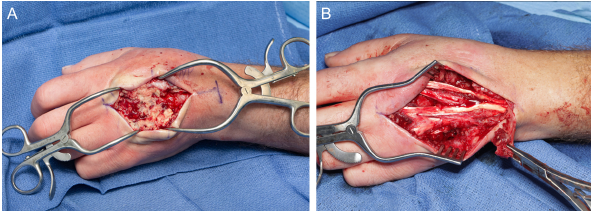
Figure 10. Intraoperative appearance of the left wrist showing (a) extensive purulent material superficial to the extensor tendons and (b) the intact extensor mechanism following debridement and irrigation.